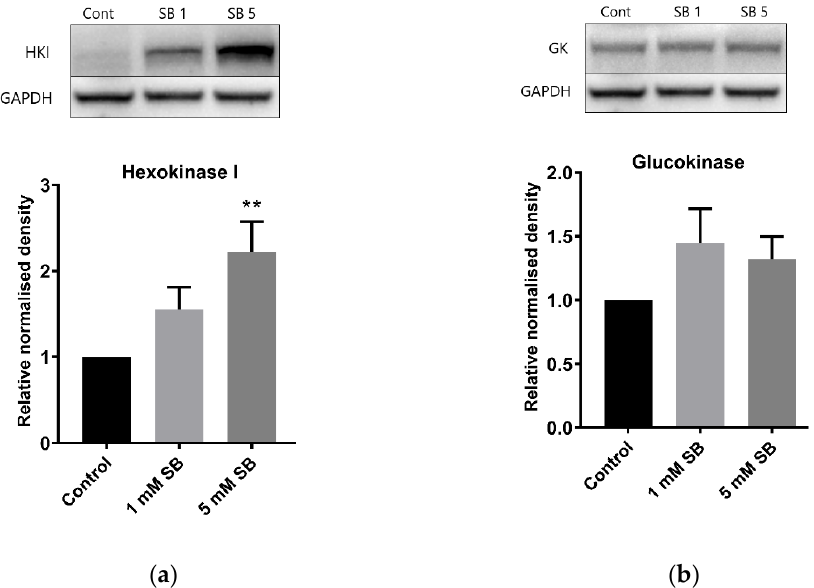
Figure 5. HepG2 immunoblots of hexokinases. Relative protein levels of ( a ) hexokinase I and ( b ) glucokinase in HepG2 cells following treatment with 1 mM or 5 mM sodium butyrate for 24 h. The graph represents the mean combined density readings as normalised to GAPDH from three independent experiments, with error bars representing SEMs. ** p < 0.01.